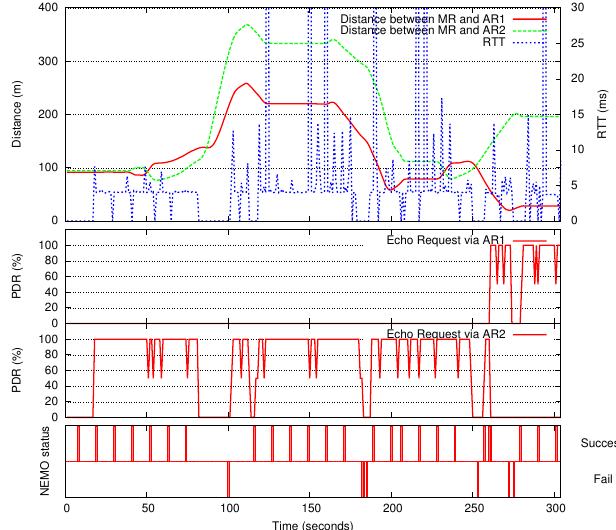
Figure 10. RTT, packet looses and mobility signaling in an ICMP evaluation under a handover scenario